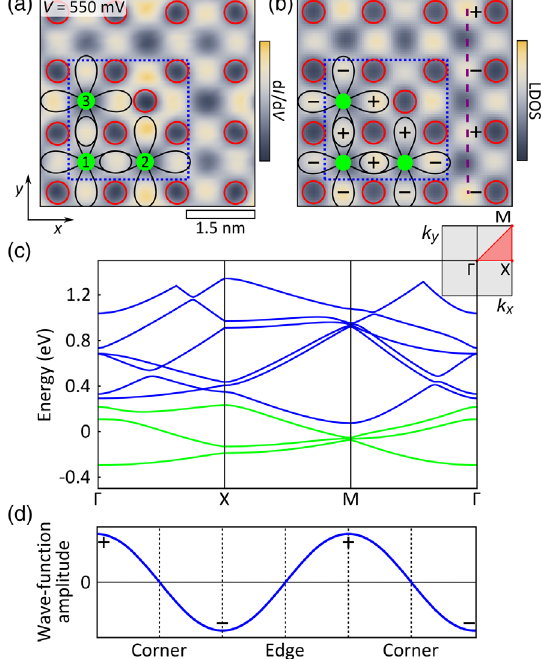
FIG. 1. (a) Differential-conductance map acquired at V ¼ 550 mV above a Lieb lattice, shown for part of the lattice. Images of the entire lattice can be found in the SM [40]. The unit cell (blue dashed box) contains three artificial-atom sites (green): one corner site (1) and two edge sites (2 and 3). The sites are generated by the configuration of CO molecules on a Cu(111) surface indicated by the red contours. The p -like orbitals in the unit cell are outlined by a black contour. The map was acquired at þ 110 pm with respect to ¼ 1 nA, V ¼ 50 mV, with a bias modulation the set point I set set ¼ 20 mV. (b) LDOS map for the same energy simulated V rms using the muffin-tin model. The p -like orbitals and the sign of the wave function are indicated in black. (c) Band structure along the high symmetry directions of the Brillouin zone (see inset) as calculated by a muffin-tin approach. The three lowest s -like bands are indicated in green, the six p -orbital bands in blue. (d) Bloch- type wave function along the purple dashed line in the muffin-tin simulation in (b). The wave function exhibits a positive maximum or negative minimum between the sites, while it is zero at the artificial-atom sites (corner and